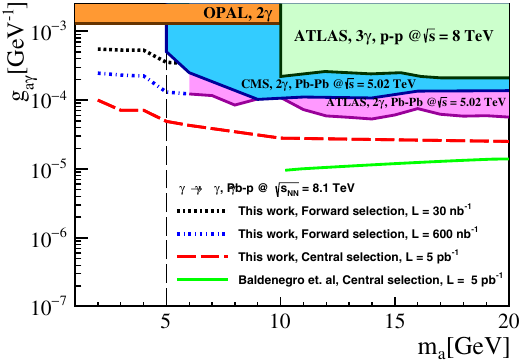
Fig. 3 Expected sensitivity to the ALP production in ultraperipheral Pb – Pb (left panel) and Pb – p (right panel) collisions at the LHC derived considering different luminosities and selection criteria. Exist-